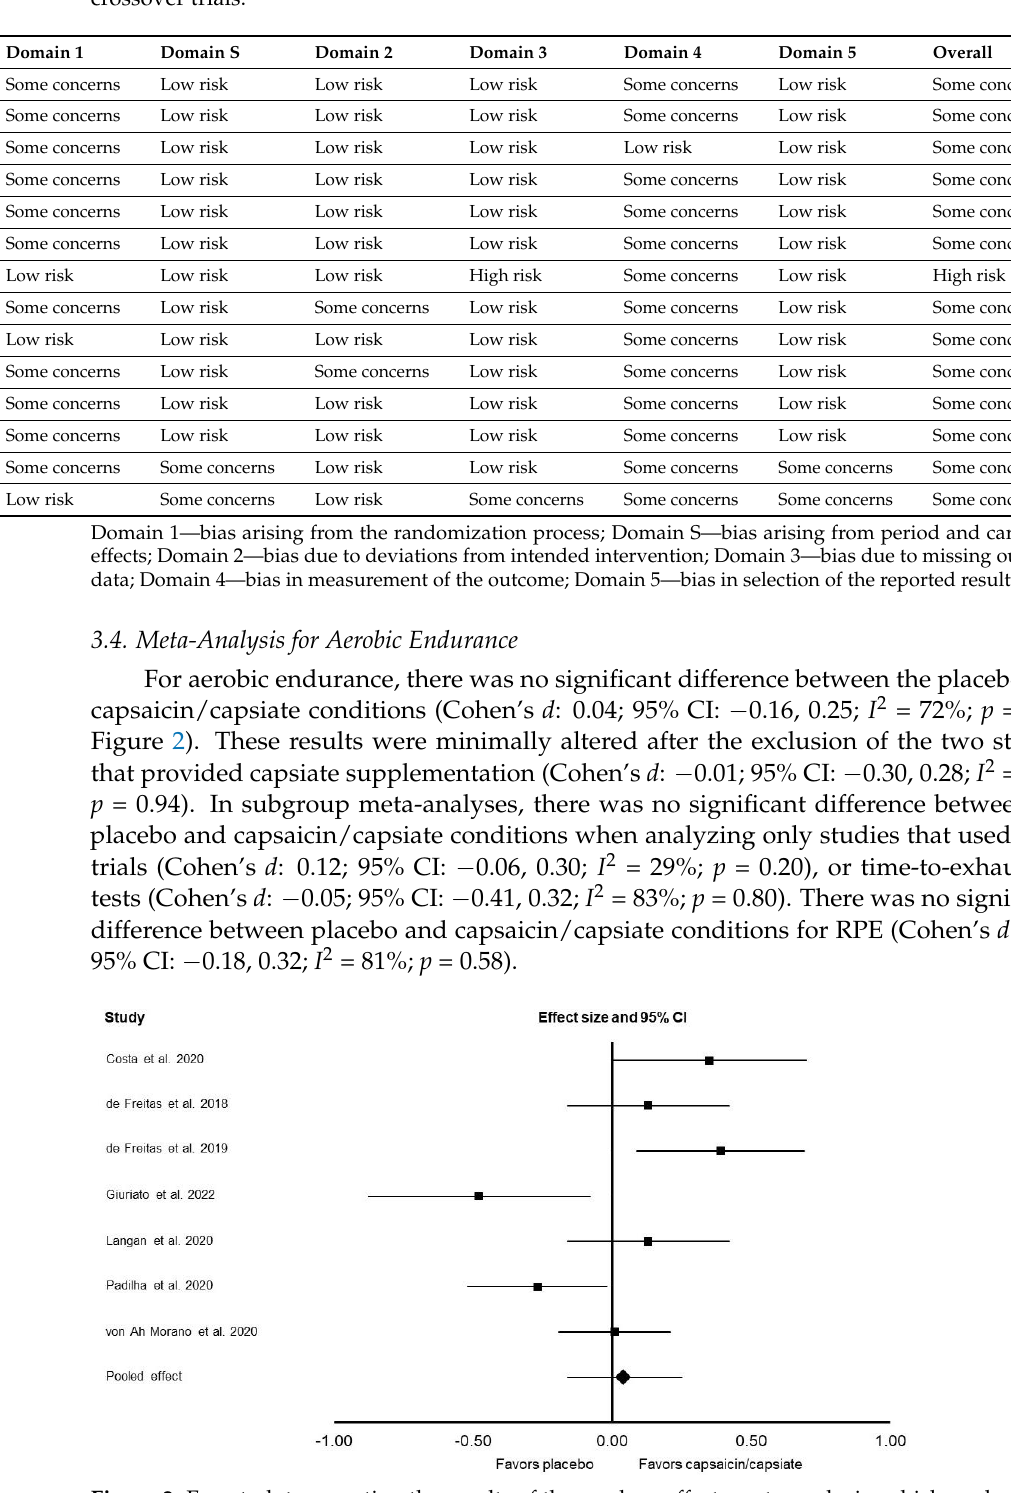
Table 2. Evaluation of risk of bias among the included studies using the risk of bias (RoB) tool 2 for crossover trials.